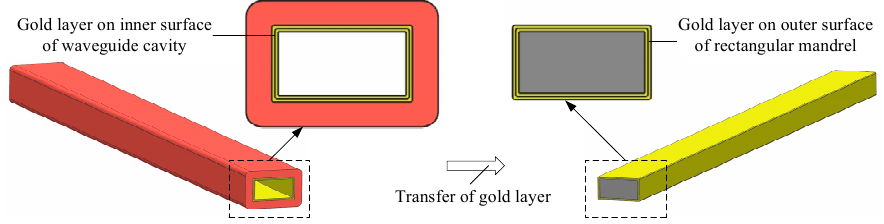
Figure 2. Schematic diagram of electrochemically deposited gold layer transferring from inner surface of waveguide cavity to outer surface of rectangular mandrel.